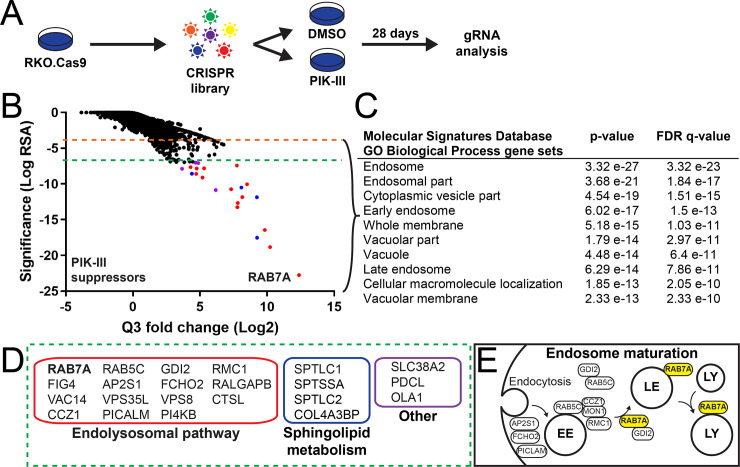
A genome-wide CRISPR screen identifies endosomal maturation pathway genes as suppressors of PIK-III.(A) Schematic of the genome-wide pooled CRISPR screening workflow for genetic modulators of VPS34 vulnerability. (B) Gene-centric visualization of the significance and Q3 fold change of sgRNAs detected in cells treated with 0.5 μM PIK-III versus vehicle control. The entire dataset is reported in S2 Table. Significance cutoff values -4 and -7 are colored in orange and green dotted lines, respectively. (C) Gene Ontology (GO) biological process enrichment analysis of PIK-III suppressor hits below the significance cutoff value of -4. The 10 most significant GO terms are shown. (D) The strongest PIK-III suppressor hits below the significance cutoff value of -7 were categorized into groups labeled the Endolysosomal pathway (red box), Sphingolipid metabolism (blue box) and Other (purple box). (E) Schematic of the endosome to lysosome transport pathway (endosome maturation) reconstituted from hits derived from the CRISPR screen. RAB7A, the top PIK-III suppressor hit, is highlighted in yellow. EE, LE and LY stand for early endosome, late endosome and lysosome, respectively.